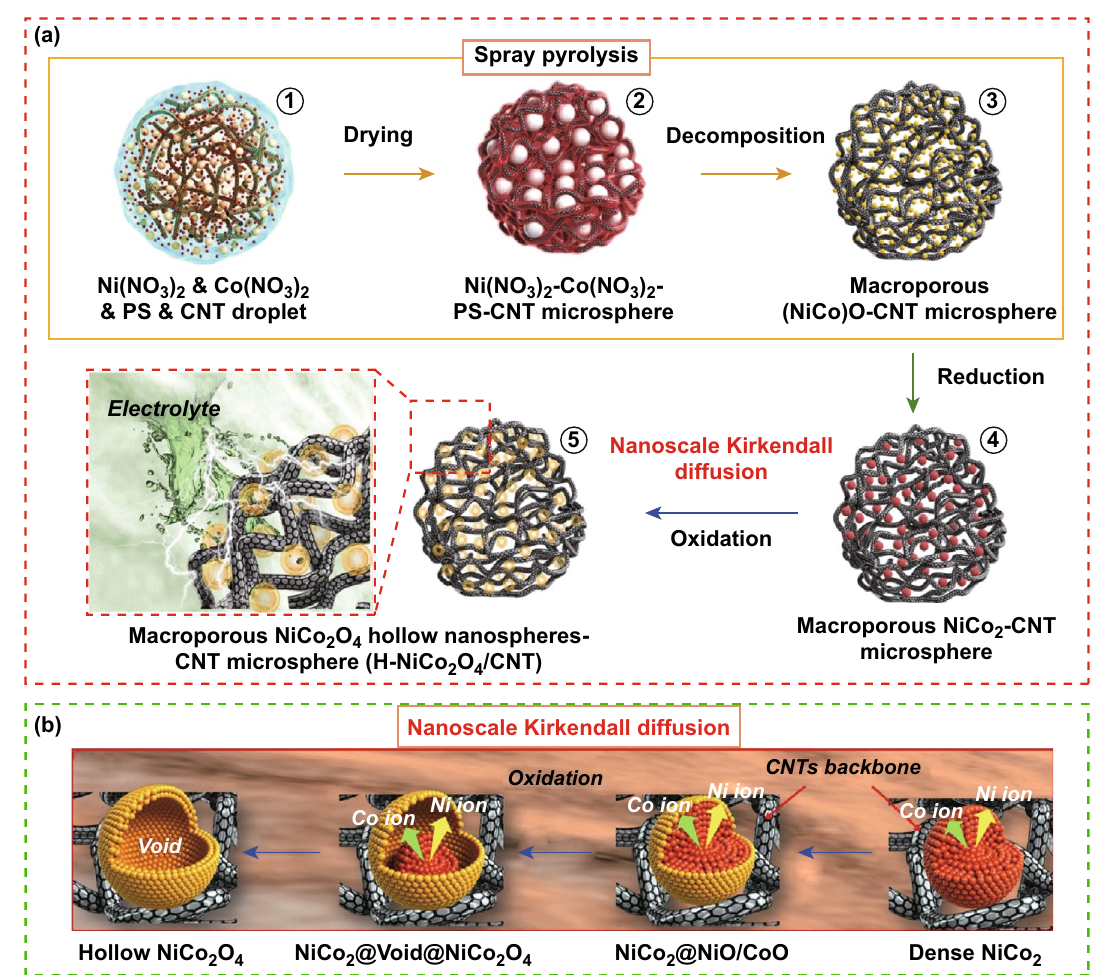
Fig. 22 Formation mechanism of 3D macroporous multi-walled carbon nanotubes microspheres densely loaded with NiCo 2 O 4 hollow nano- spheres. Reproduced with permission from Ref. [221]. Copyright © 2017 Elsevier